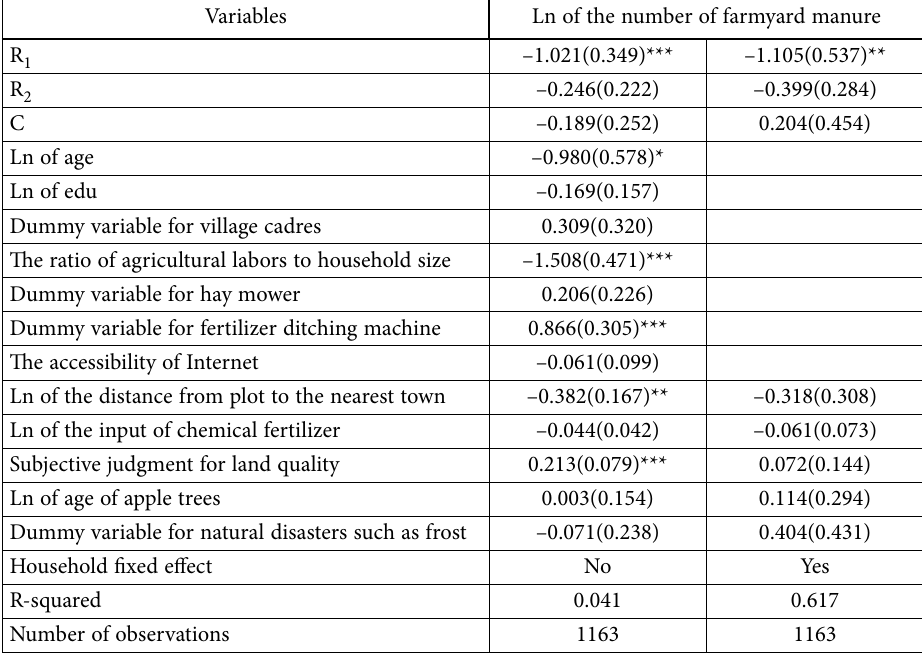
Table 3. Tenure security and farmland